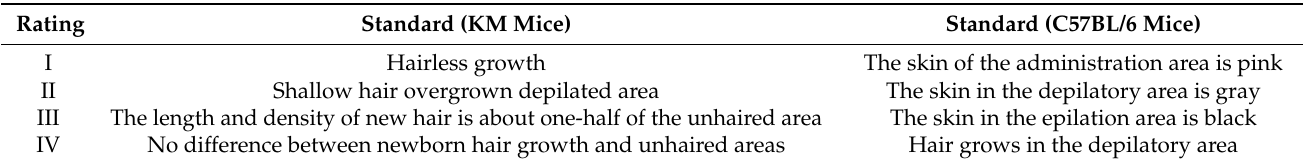
Table 3. Rating standard table of KM mice and C57BL/6 mice newborn hair